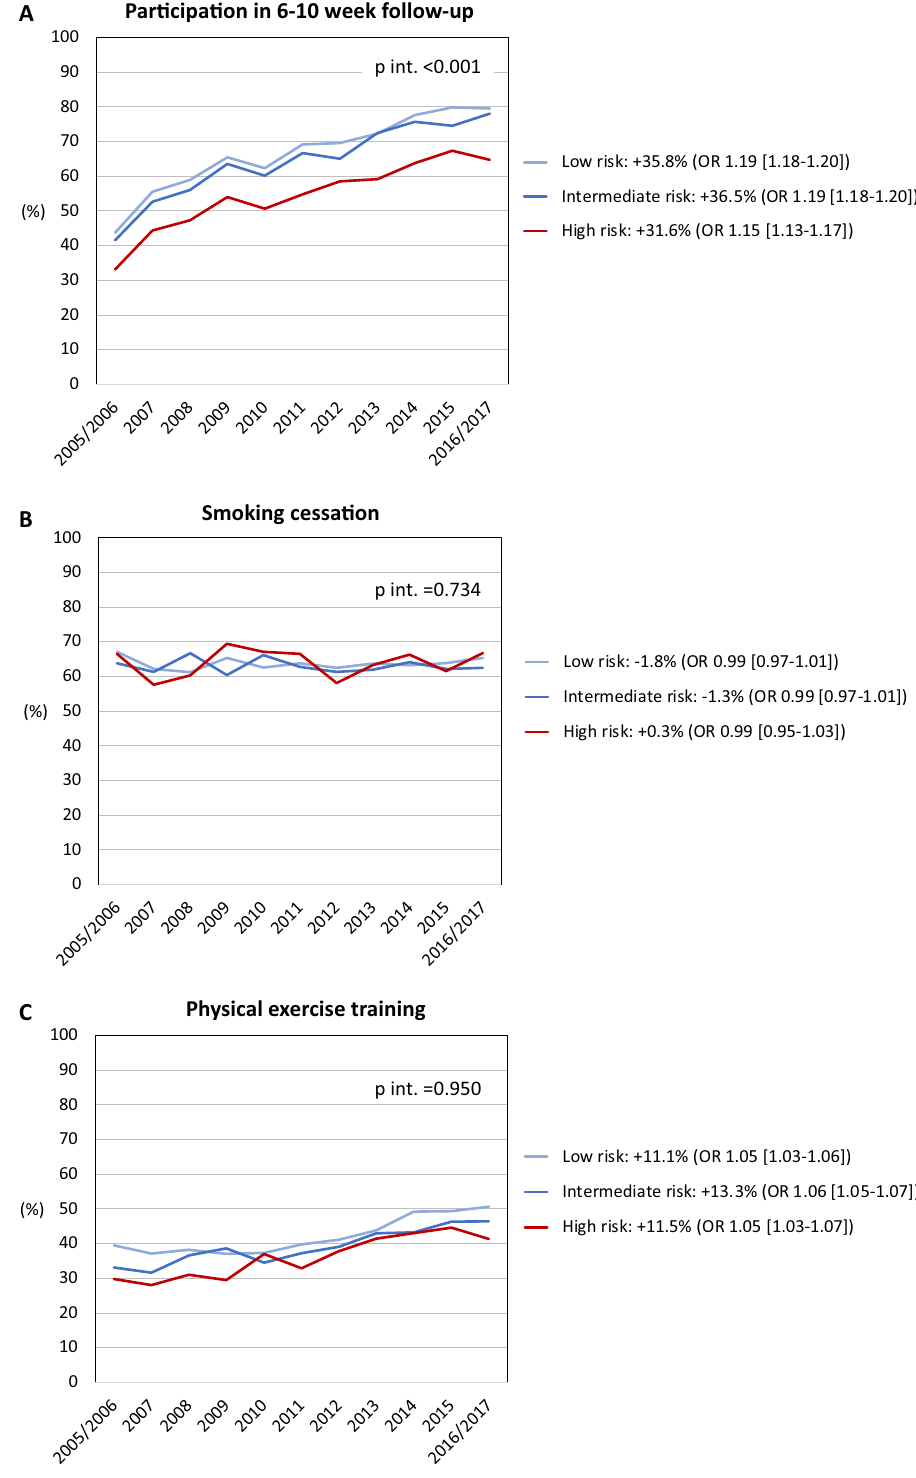
Figure 5. Temporal changes in follow-up and secondary preventive measures. ( A ) participation in the 6–10 week follow-up; ( B ) self-reported smoking cessation; ( C ) participation in exercise training. Percentages refer to changes in the rates of follow-up participation and achievement of secondary preventive measures from 2005/2006 to 2016/2017. p int. refers to the interaction between year of admission and risk group on the utilization of coronary interventions. Odds ratios (OR; with 95% confidence intervals) describe the adjusted associations of the year of admission (2005/2006 vs. 2016/2017) with coronary interventions. Only patients eligible for the 6–10 week follow-up had been